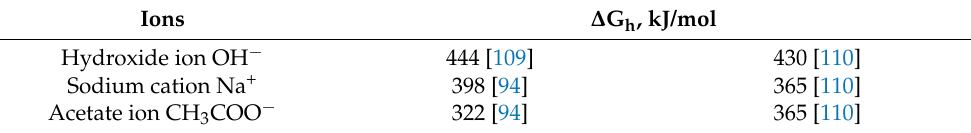
Table 2. Hydration energy of